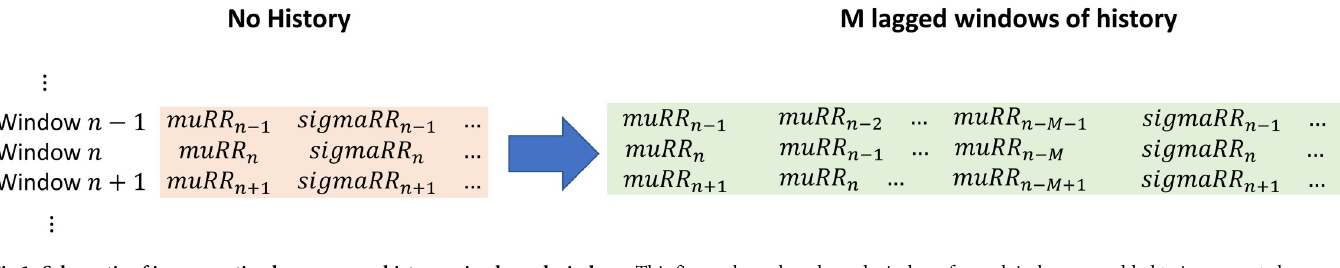
Fig 1. Schematic of incorporating longer-range history using lagged windows. This figure shows how lagged windows for each index were added to incorporate longer- range history. For example, if w is 30 seconds and h is 120 seconds, that results in M = 4 lagged windows for each index, resulting in a total of 5 features in the model from each